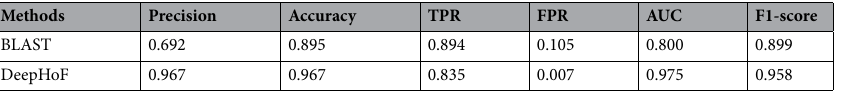
Table 1. Performance metrics of DeepHoF and BLAST. TPR true-positive rate, FPR false-positive rate, AUC area under the